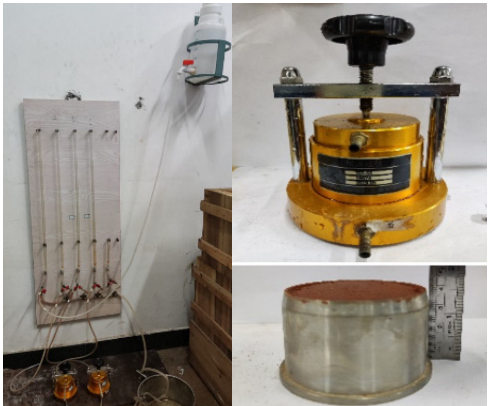
Figure 2. Permeability test apparatus and test sample.